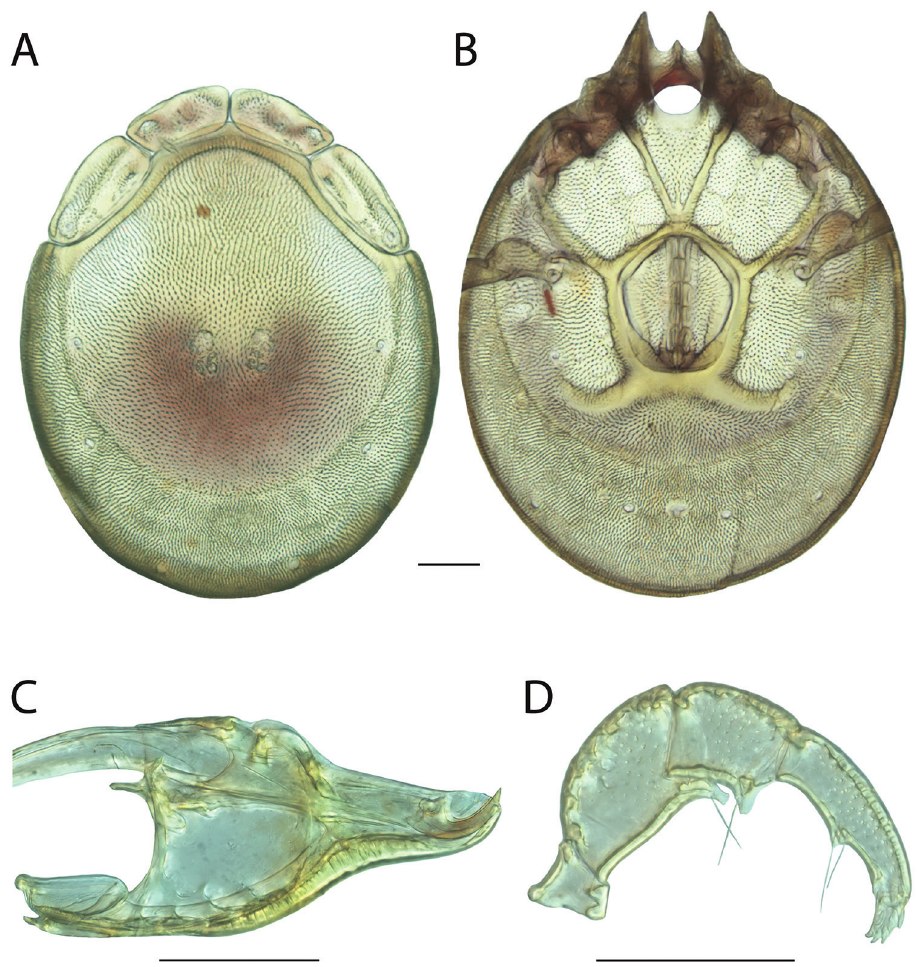
Figure 241. Torrenticola sierrensis female: A dorsal plates B venter (legs removed) C subcapitulum D pe- dipalp (setae not accurately depicted). Scale = 100